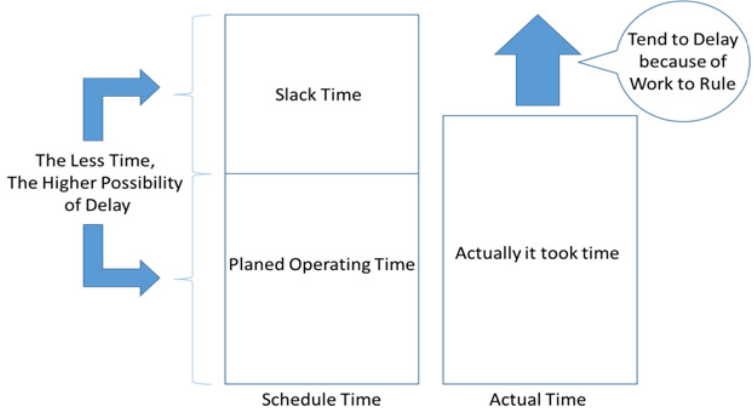
Figure 3. Risk by shortening